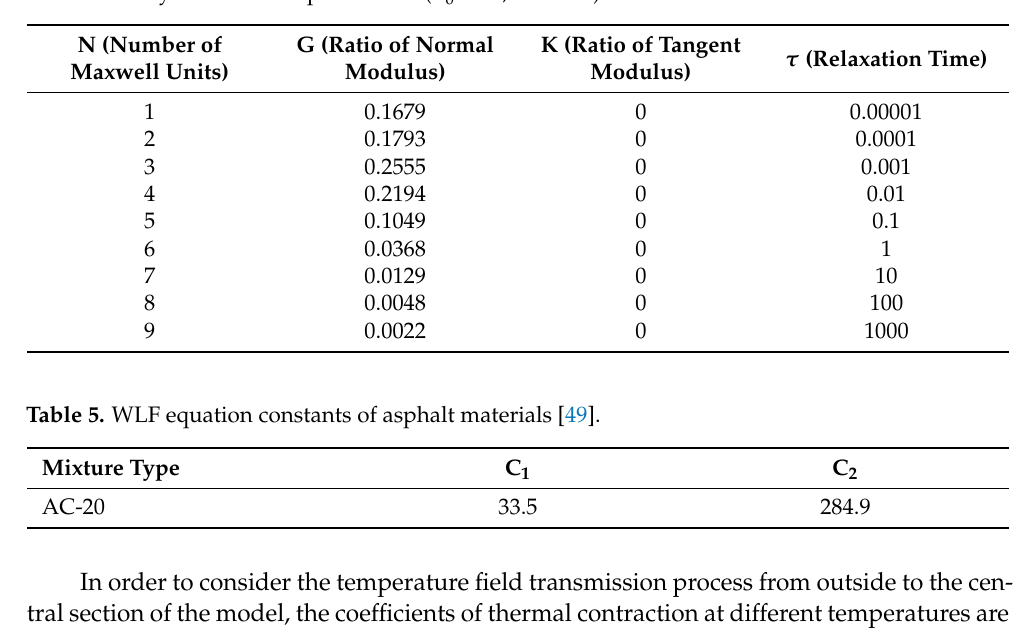
Table 4. Prony series model parameters ( E 0 = 14,500 MPa).